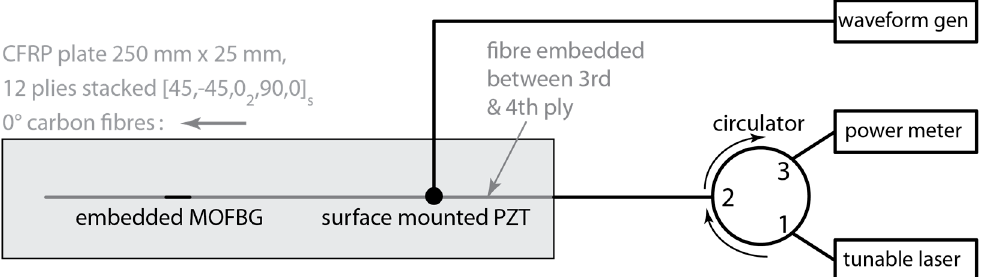
Figure 3. A schematic of the experimental setup.